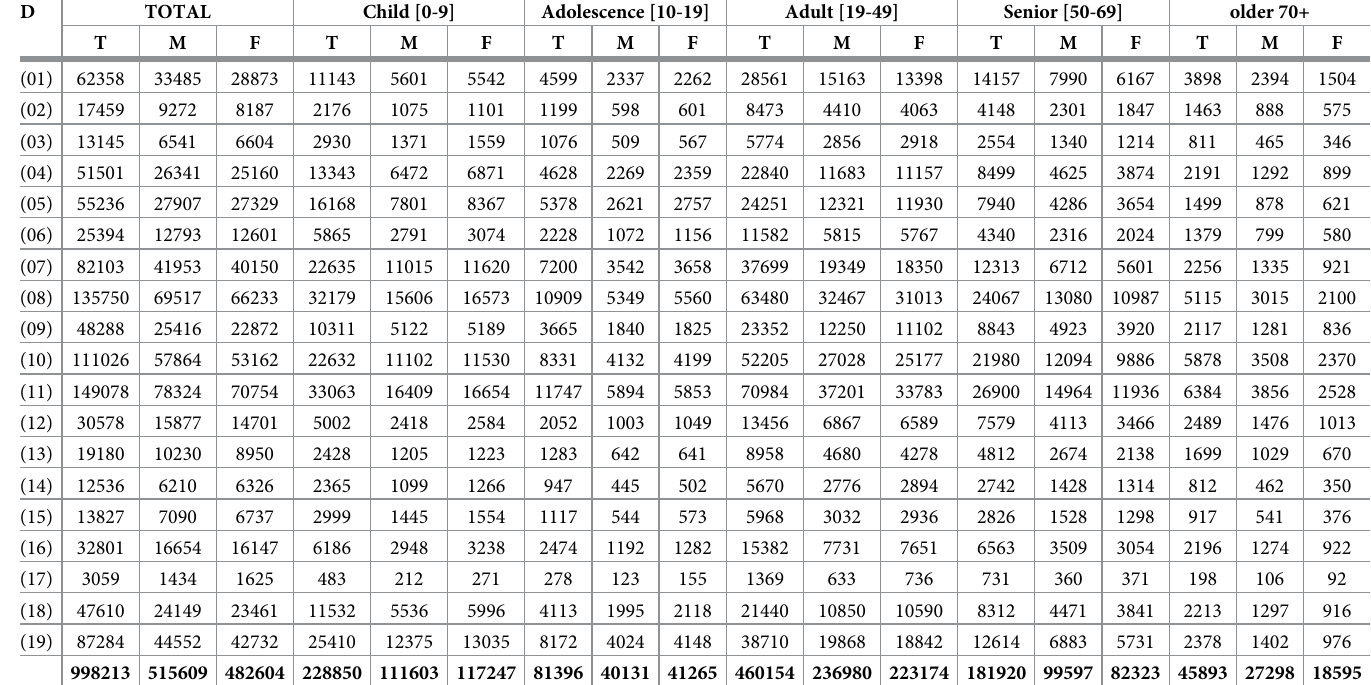
Table 3. Demographic information of virtual people grouped by District . District (D), Total(T), Male(M), Female(F). D